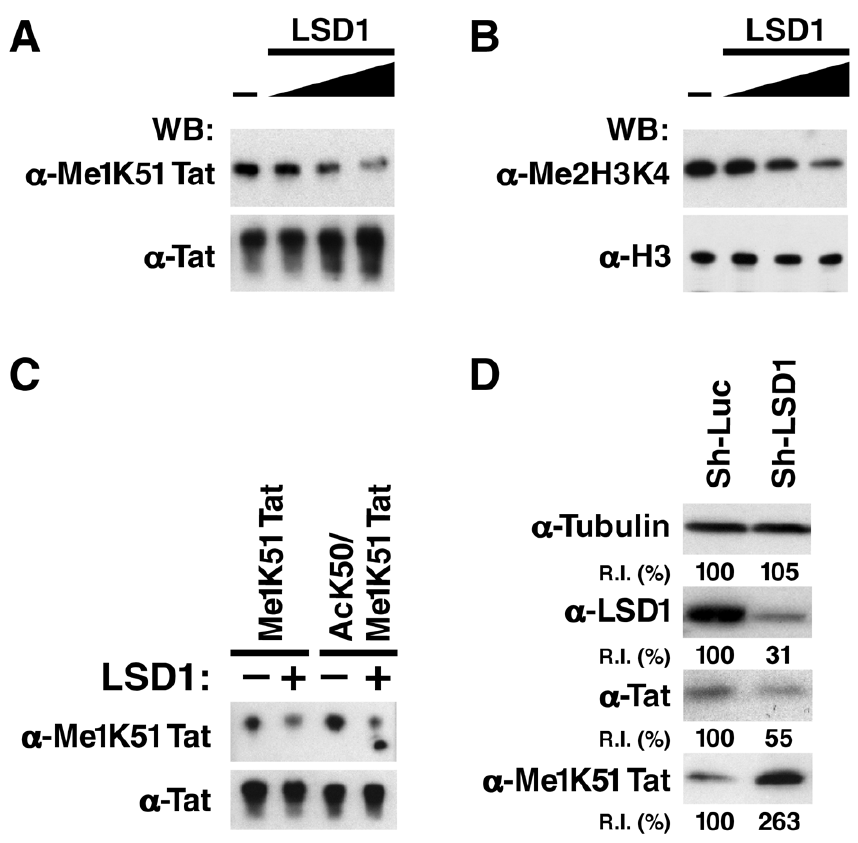
Figure 4. LSD1/KDM1 demethylates mono-methylated K51 in Tat. (A) Synthetic K51-mono-methylated Tat proteins were incubated with increasing amounts of recombinant LSD1/KDM1 (0, 0.5, 1, 2 m g) for 1 h at 37 u C. Reaction products were analyzed by western blotting using a -Tat, a - Me1K51 Tat antibodies. (B) Purified histone proteins were subjected to the same procedure as in A and analyzed by a -Me2H3K4 or a -histone H3 antibodies. (C) Synthetic K51-mono-methylated Tat or K50-acetylated/K51-monomethylated Tat proteins were incubated with 1 m g of recombinant LSD1 as described in A. (D) Increase in K51-monomethylation of Tat in LSD1 shRNA-infected J-Lat A2 cells. Whole cell lysates isolated from J-Lat A2 cells infected with shRNAs directed against LSD1 or control shRNAs and stimulated with TNF a were analyzed by western blotting with indicated antibodies. Band intensities were quantified using ImageJ Software (NIH). R.I.: Relative intensities of bands as compared to the control-vector transduced cells (100%).